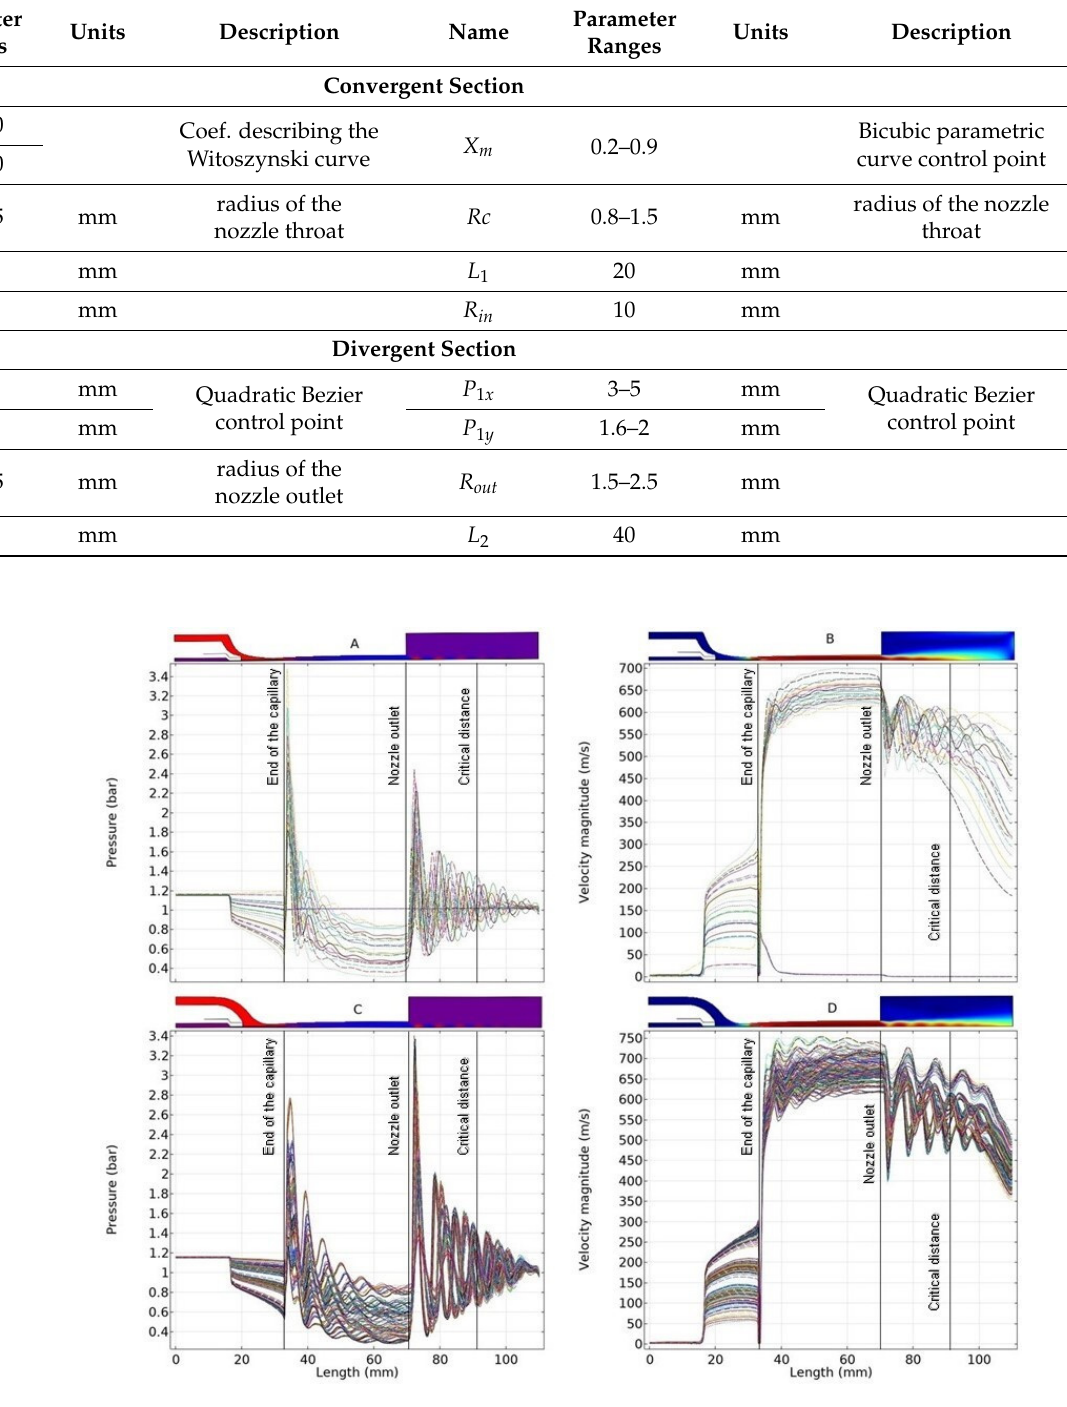
Figure 2. Numerical calculation results using different parameters listed in Table 2. ( A ) gas flow pressure and ( B ) gas flow velocity for Witoszynski curve nozzle geometry; ( C ) gas flow pressure and ( D ) gas flow velocity for Bicubic curve nozzle geometry.